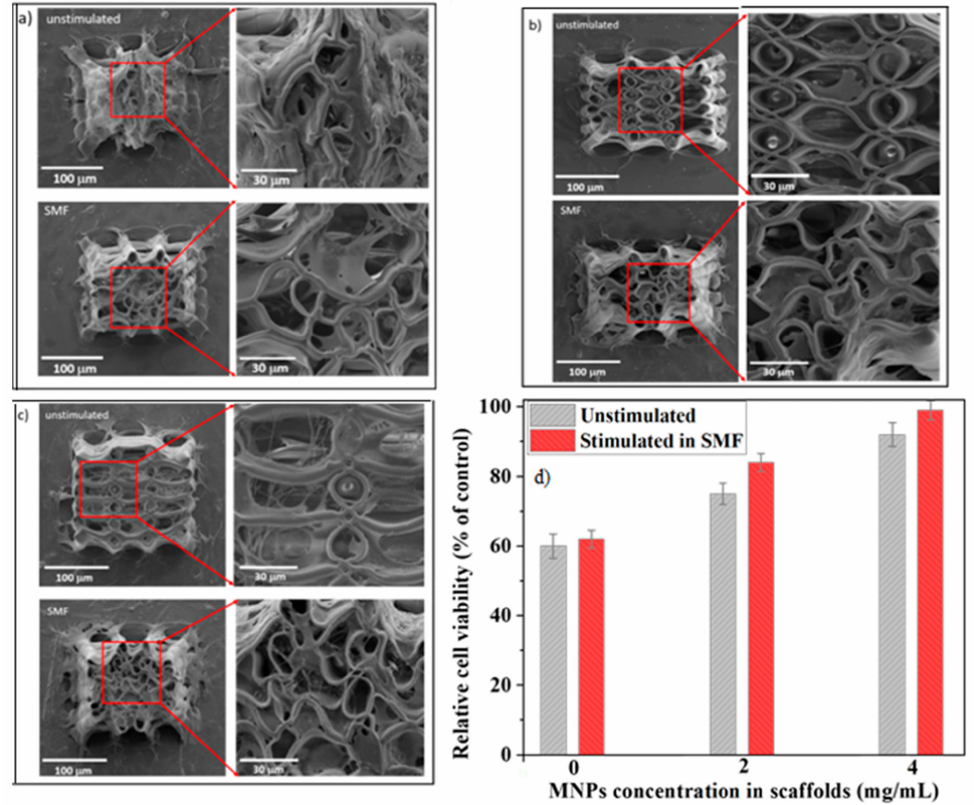
Figure 7. Scanning Electron Microscopy (SEM) micrographs illustrating the cells attached on sca ff olds with MNPs concentrations of: ( a ) 0 mg / mL; ( b ) 2 mg / mL; ( c ) 4 mg / mL, after 3 days of cultivation, in the absence (upper panel) and in the presence (lower panel) of static magnetic field (SMF). Left panels: cells growing on the sca ff olds. Right panels: insets; ( d ) relative cell viability as a function of MNPs concentration in the sca ff olds; except for 0 mg / mL MNPs concentration, the results were statistically significant ( p <